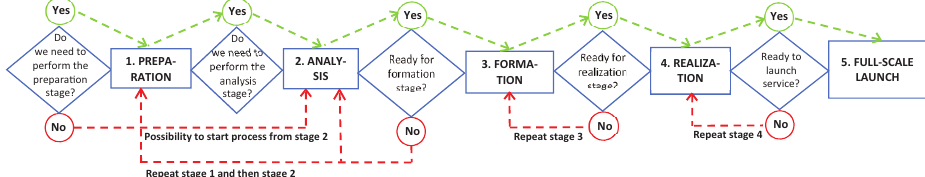
Figure 2. Algorithm for the implementation of the 3C service development model (source: Skačkauskienė et al.,